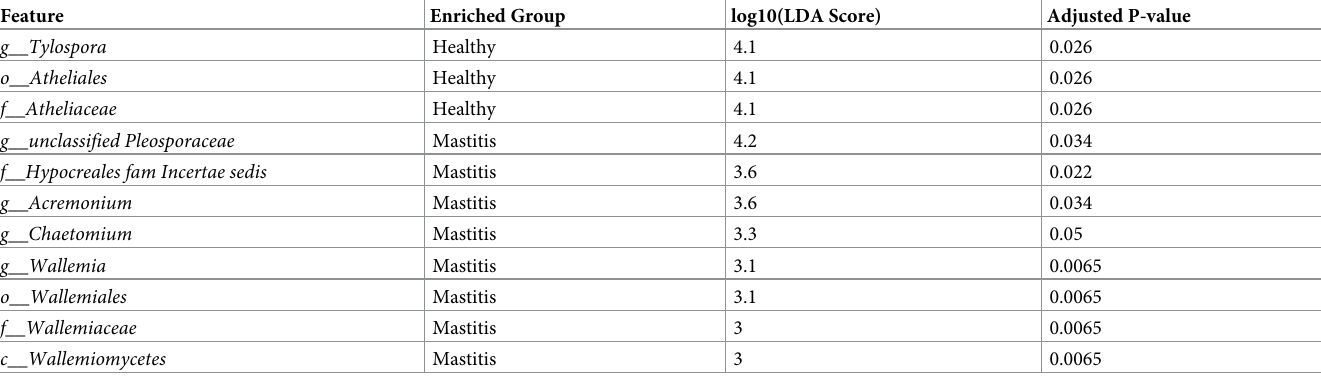
Table 6. Lefse marker table at taxonomic level for healthy and mastitis samples for